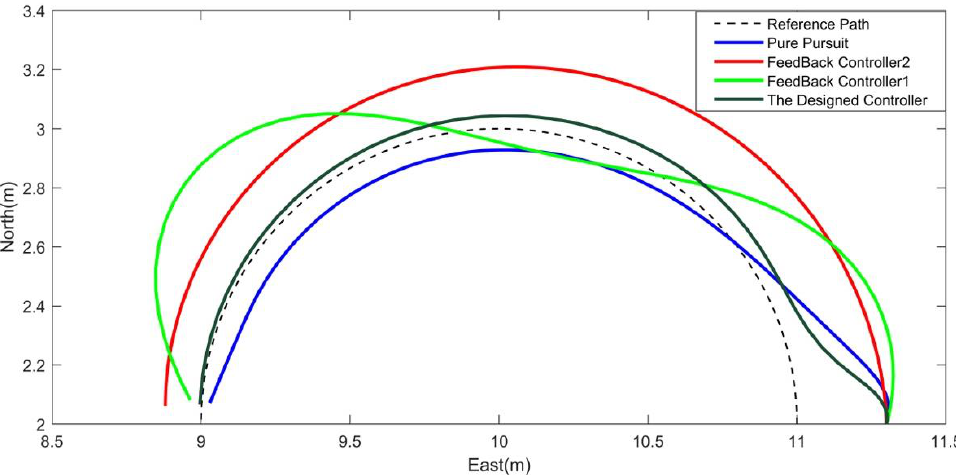
Figure 11. Curve tracking trajectory comparison.